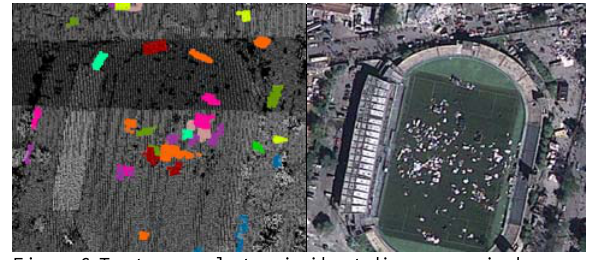
Figure 6 Tent camp clusters inside stadium recognised as seg- ments on collapsed buildings. The GeoEye image (right) was captured one week before the ALS data (left).